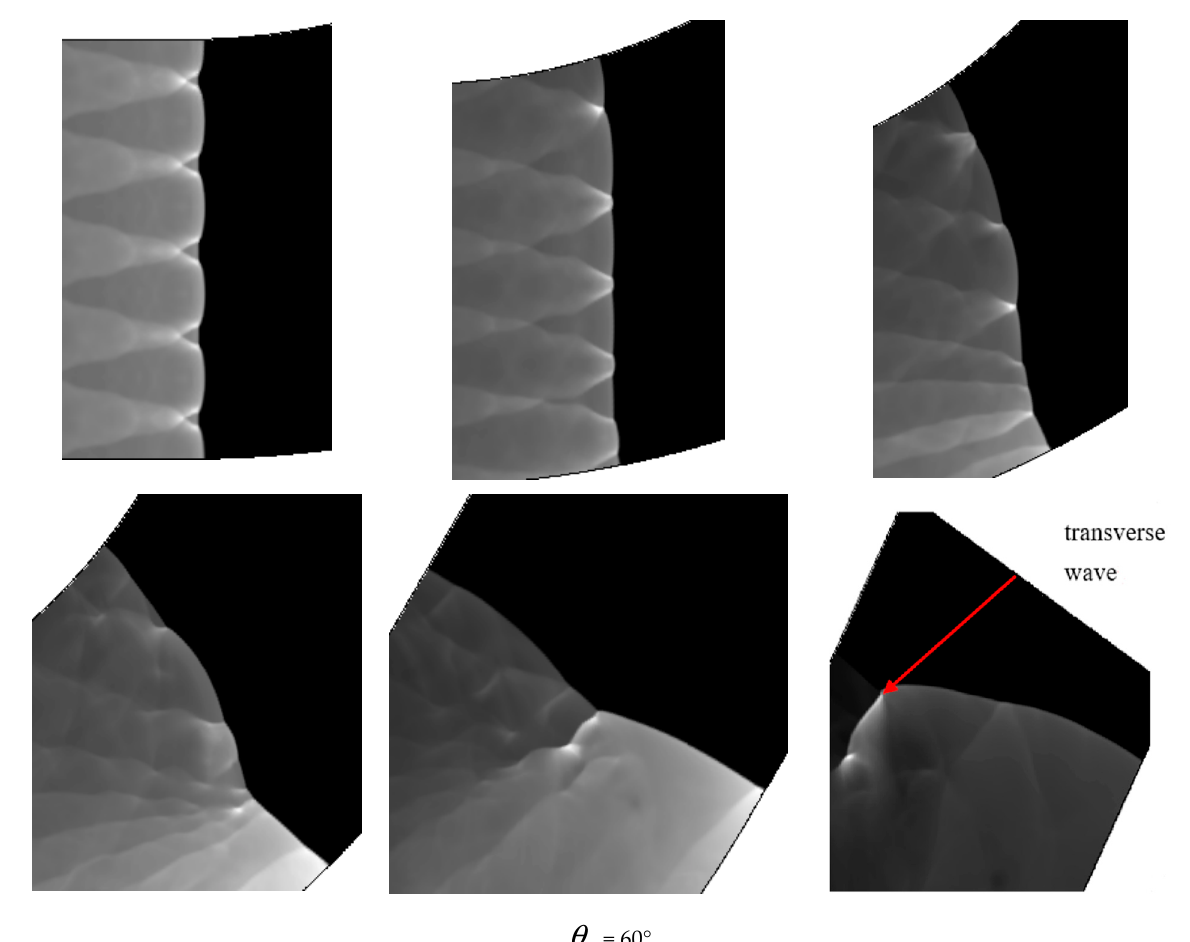
Figure 10. Evolution process of detonation wave in curved pipe.